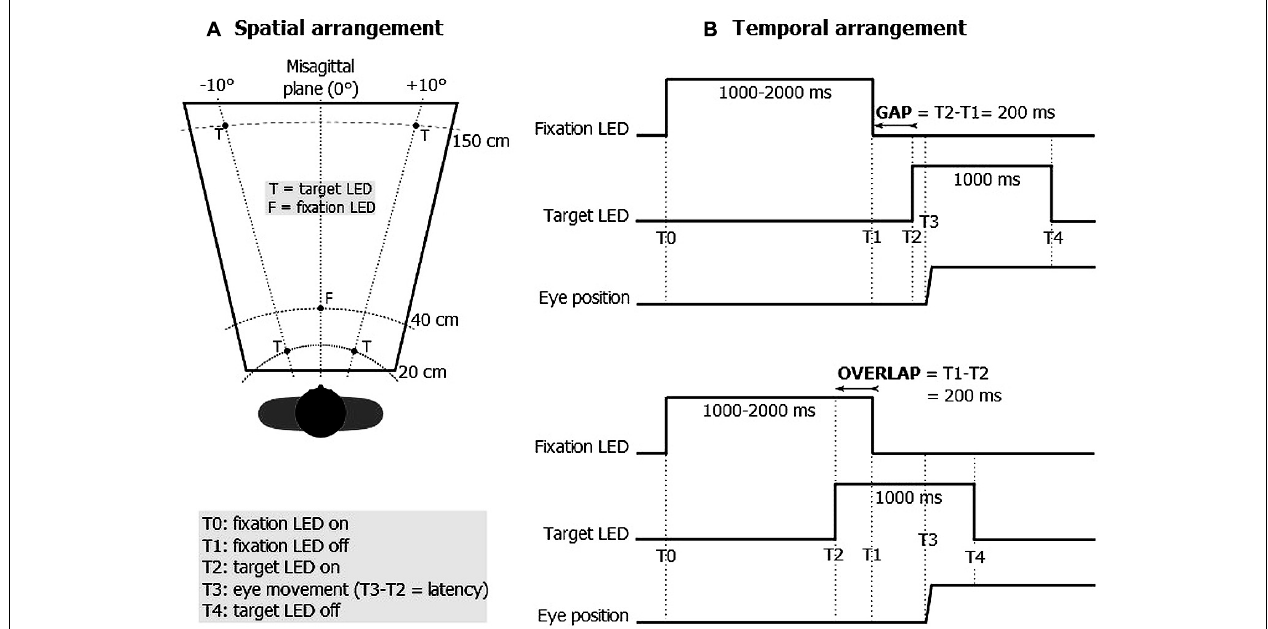
FIGURE 1 | Illustration of the spatial (A) and temporal (B) arrangement of the